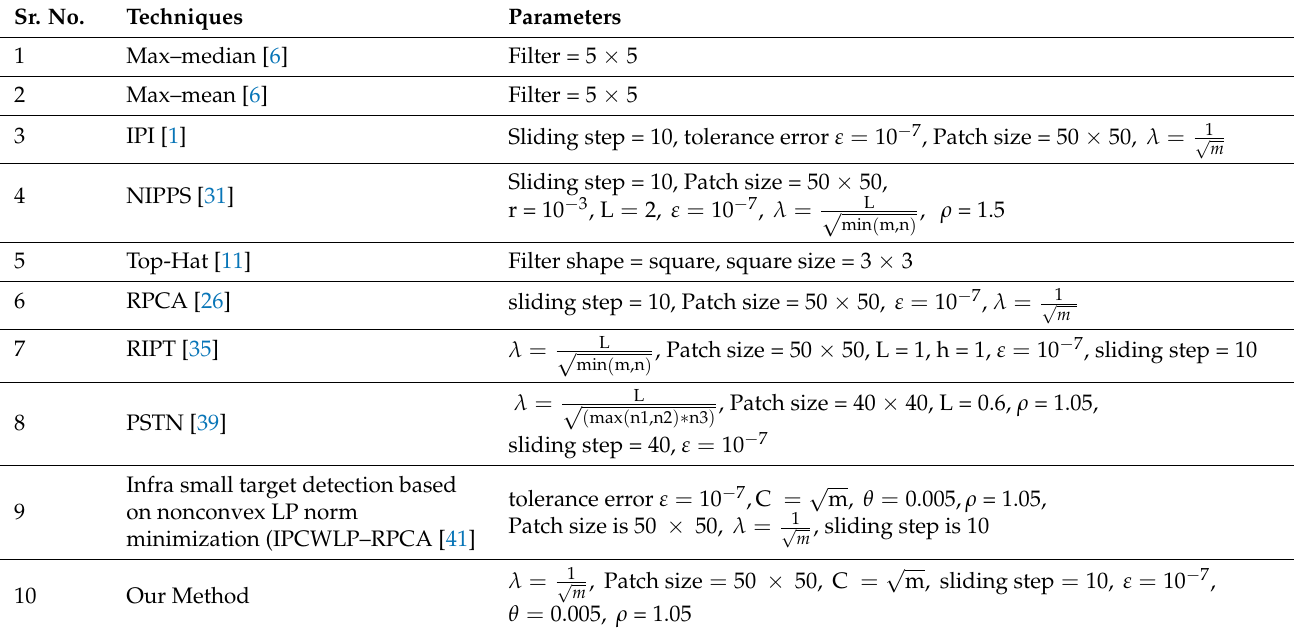
Table 3. Summary of the different parameters used in the